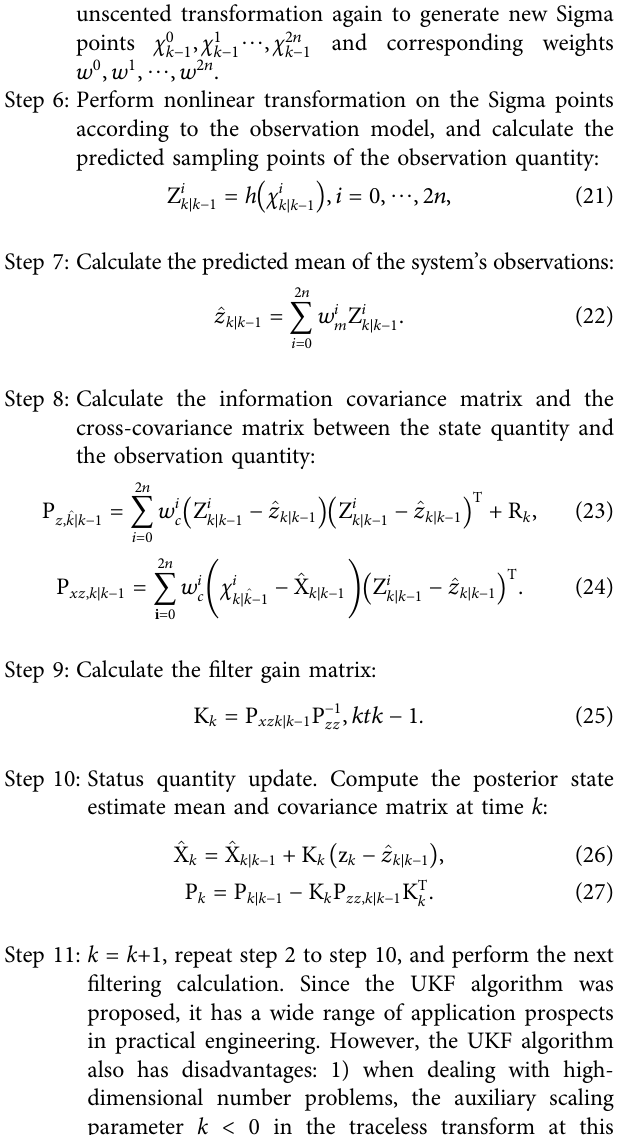
particle fi lter and an improved unscented Kalman particle fi lter algorithm. The basic idea of the improved